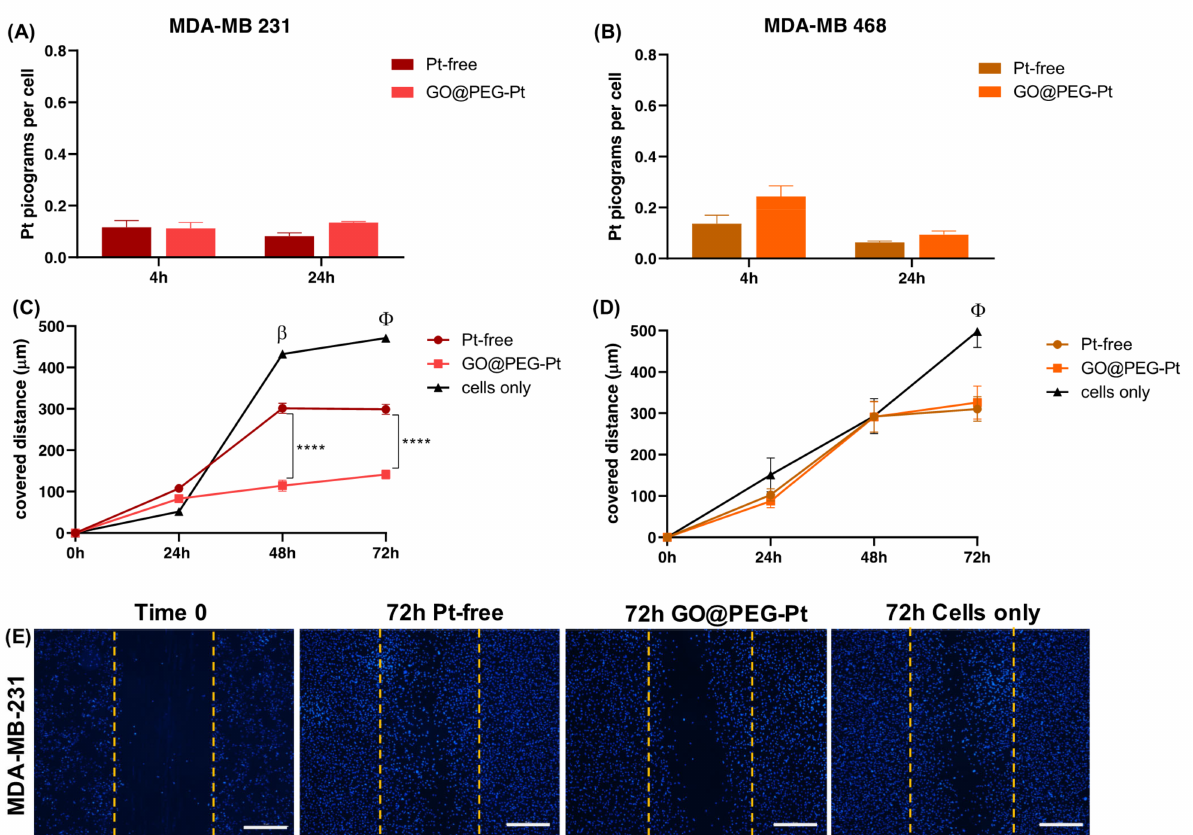
Figure 9. Human breast adenocarcinoma cell lines. ICP-OES on MDA-MB-231 ( A ) and MDA-MB-468 ( B ). Scratch test on MDA-MB-231 ( C ) and MDA-MB-468 ( D ); β : Pt-free vs. cells alone and